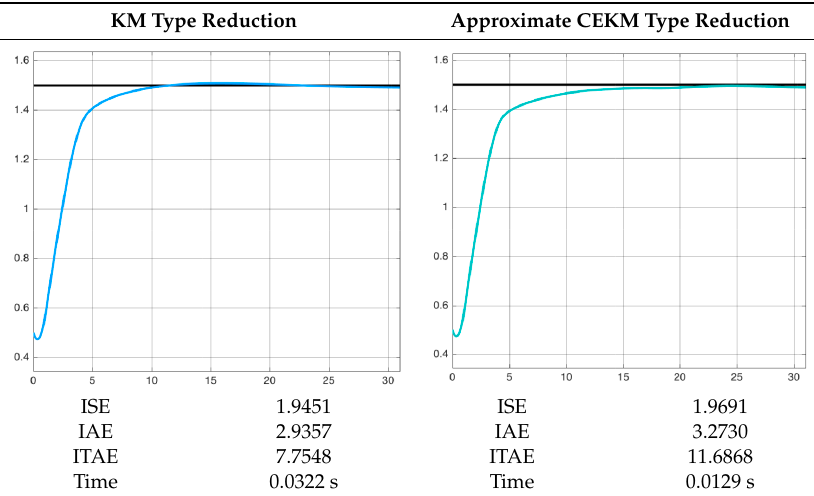
Table 9. Performance comparison.